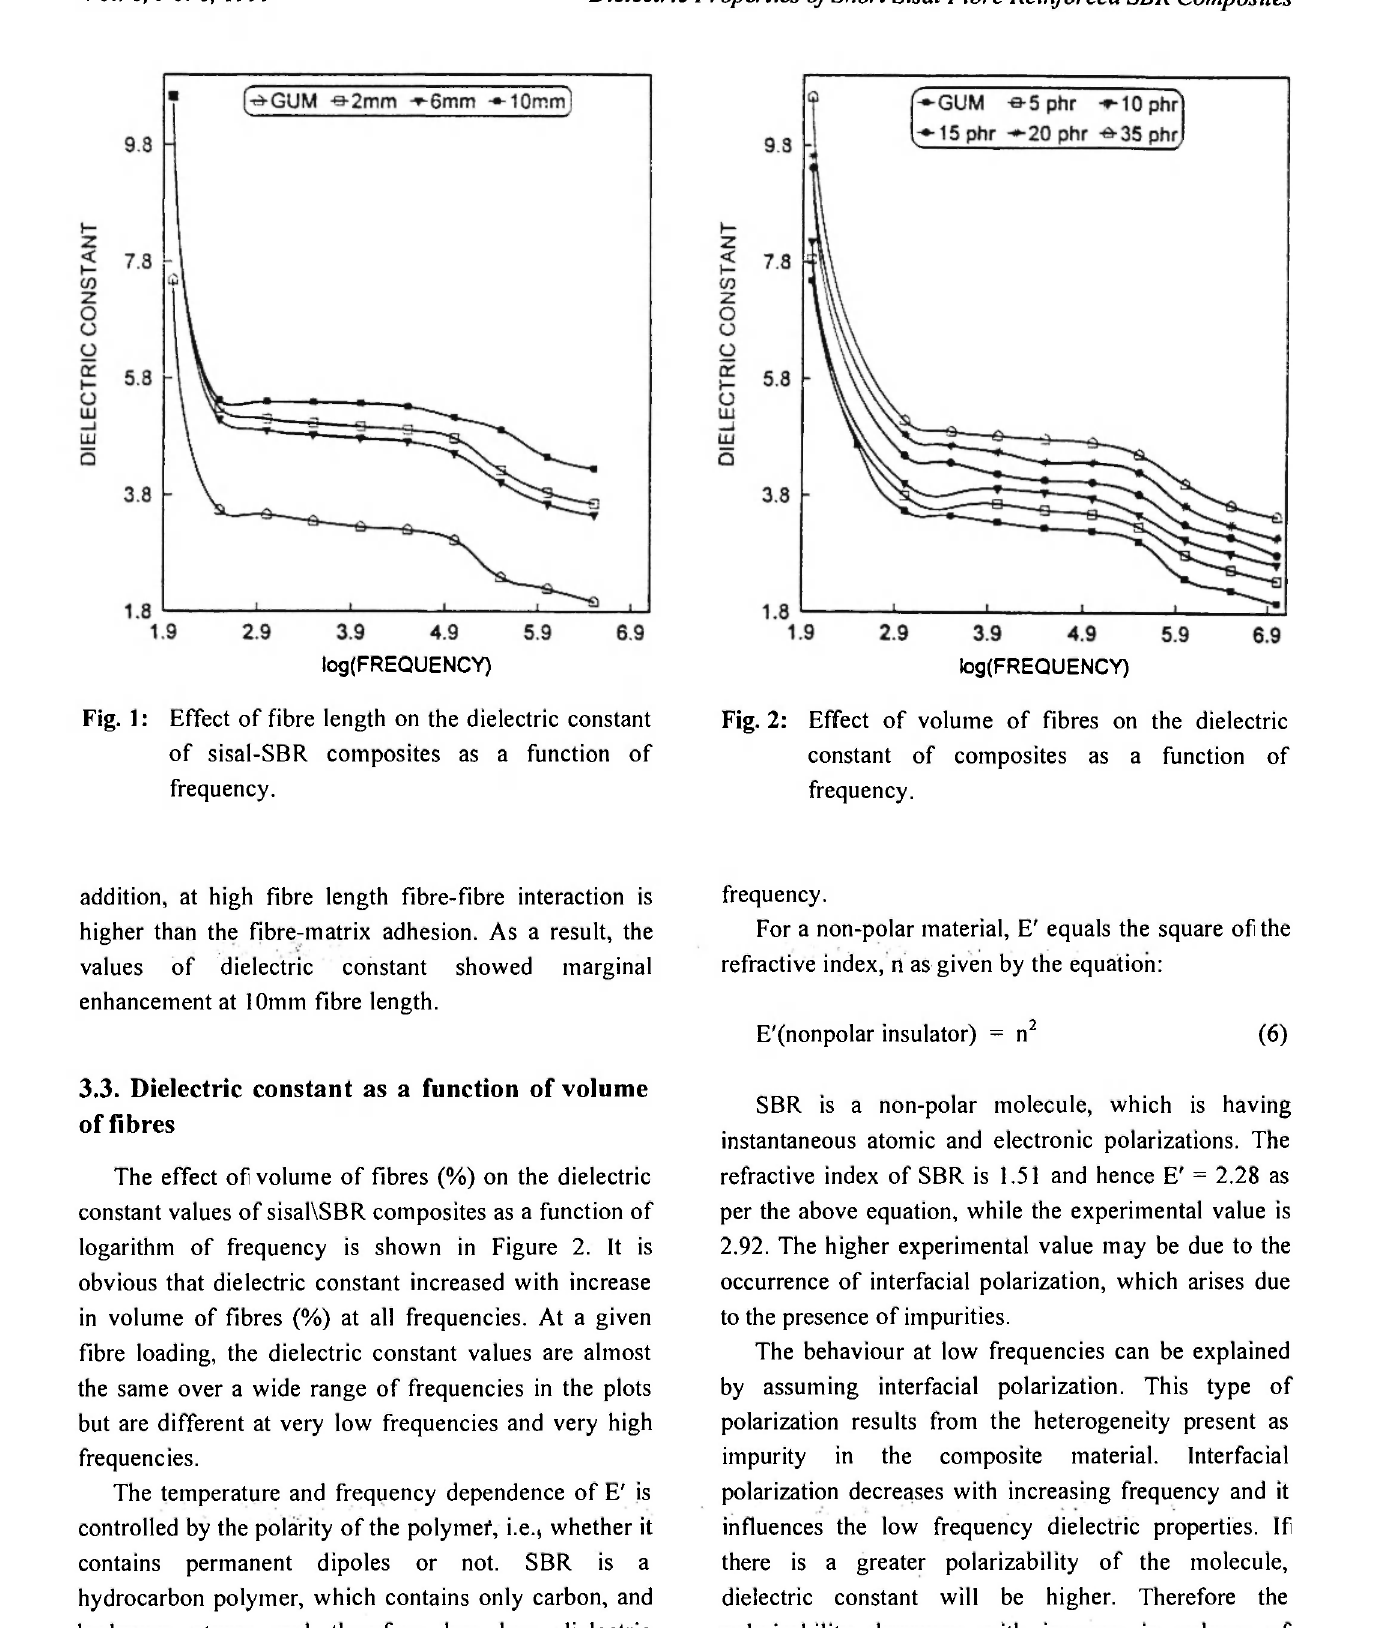
Fig. 1: Effect of fibre length on the dielectric constant of sisal-SBR composites as a function of frequency.